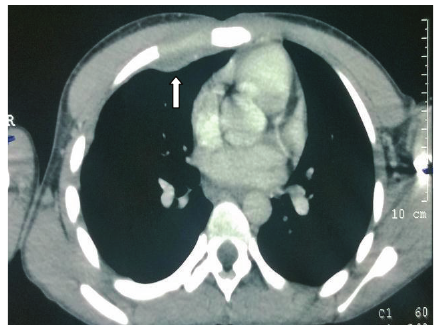
Figure 2: Axial CECT image at lesion level in mediastinal window showing well loculated eliptical hypodense collection with periph- eral enhancement on the anterior chest wall with no evidence of mediastinal lymphadenopathy.